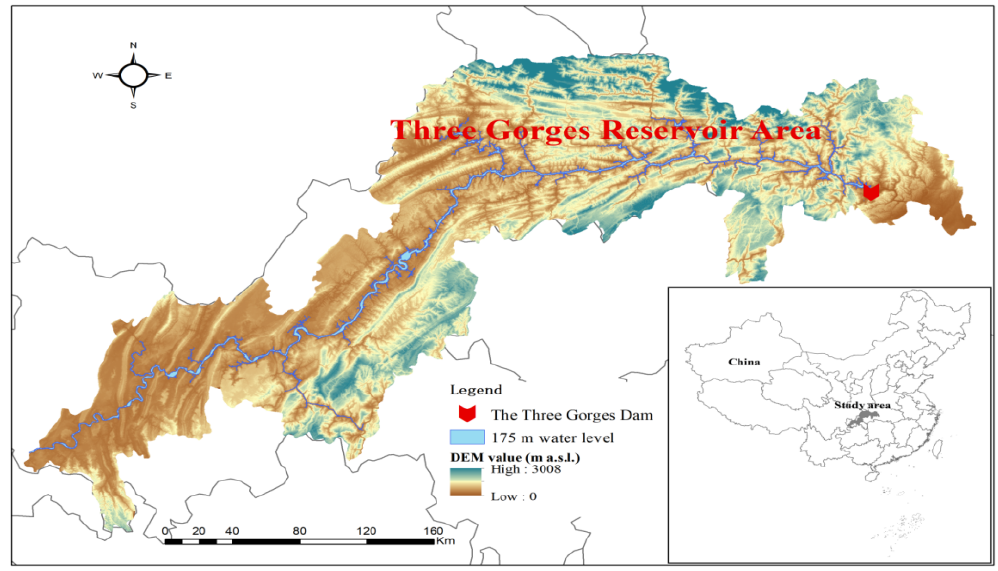
Figure 1. Geographic location of the study area.